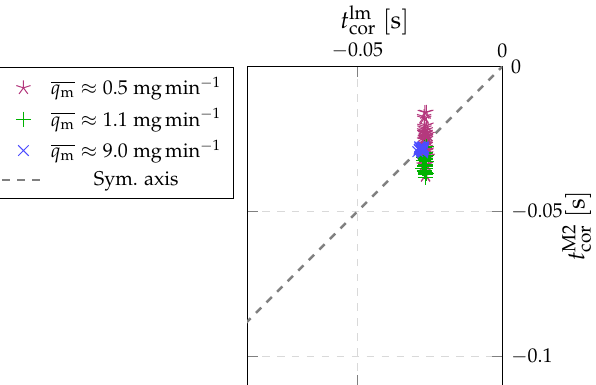
Figure 11. Results of correction time measurement obtained with Method 2 in combination with values according to defined model for different flow